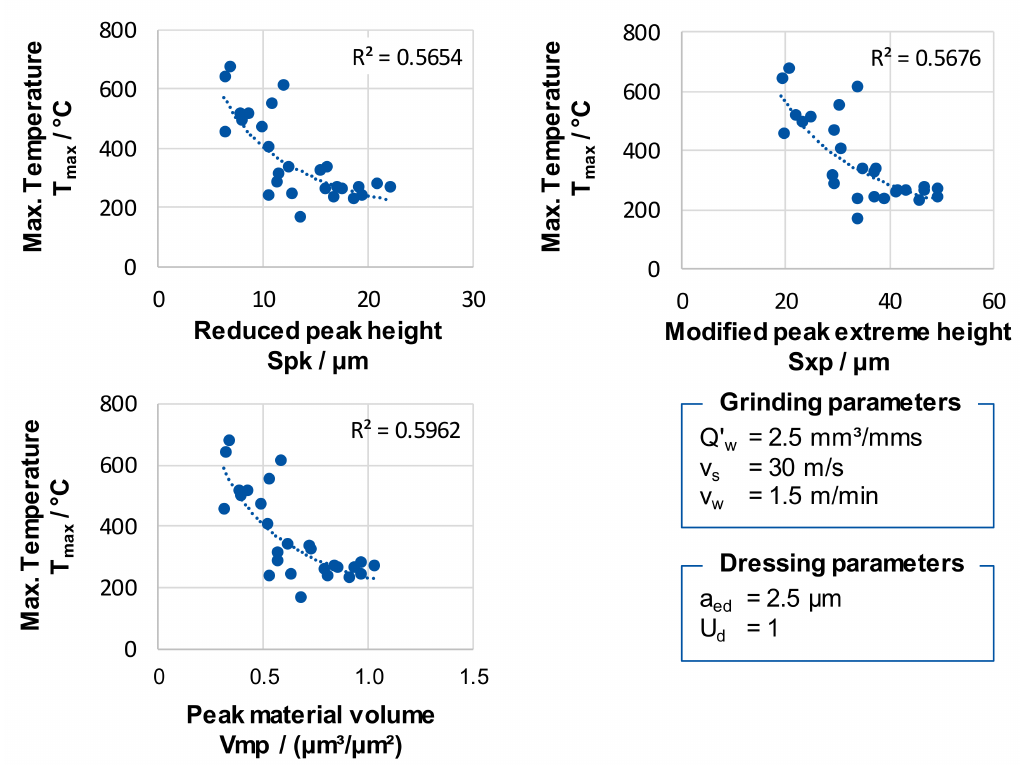
Figure 9. Correlation between volume and functional topography parameters and the process